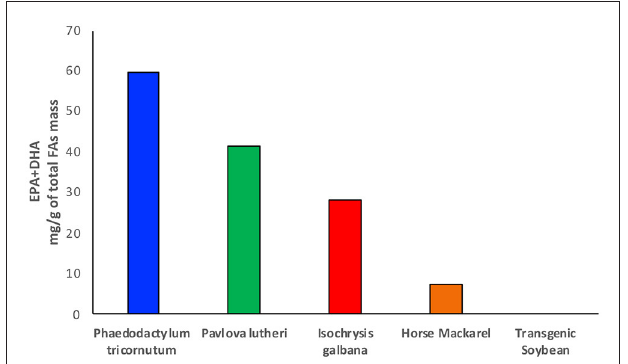
FIGURE 3 | The bar chart shows the amounts of EPA and DHA produced in microalgae and compared with omega-3 oil rich fish and transgenic soybean plants. Data taken from Amjad Khan et al. (27) and Adarme-Vega et al. (53).